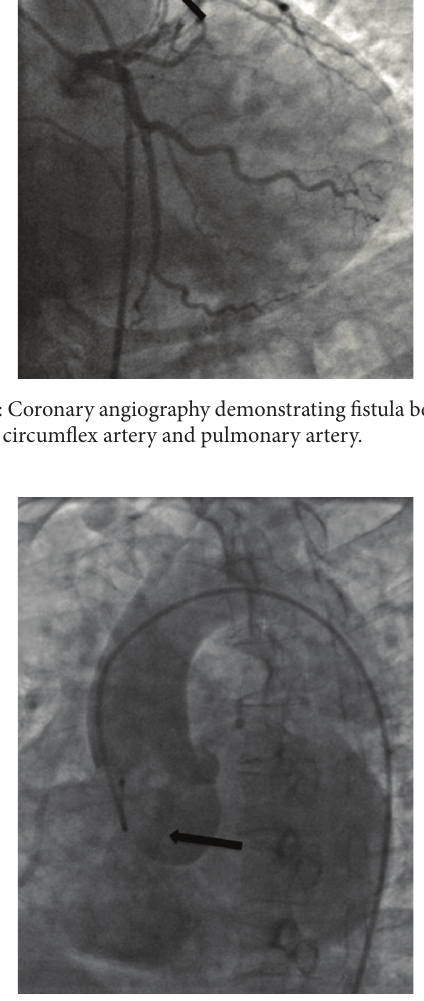
Figure4:Aorticangiographydemonstratingaorticrightventricular